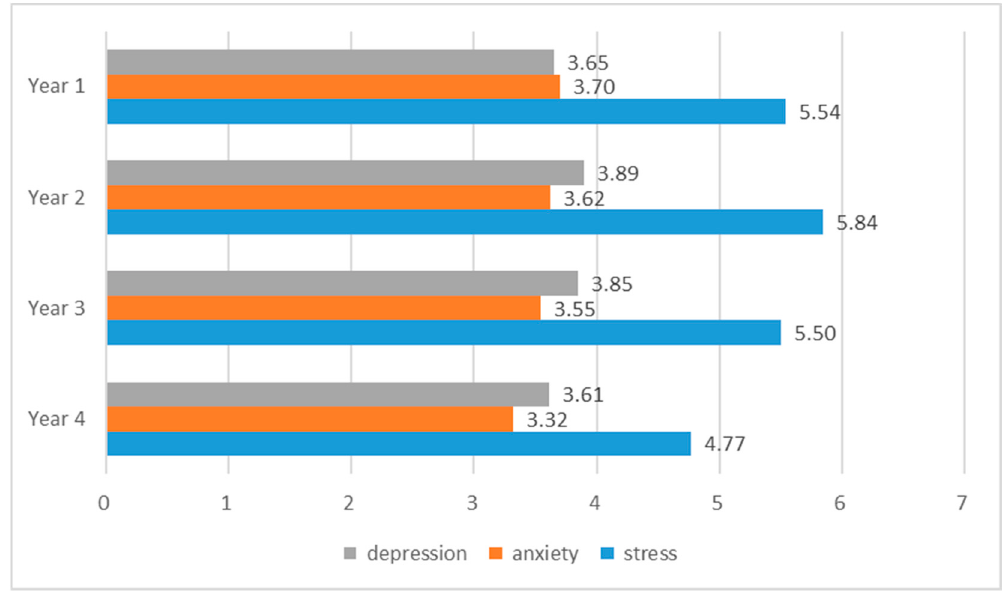
Figure 1. Comparison of means in depression, anxiety and stress across years.